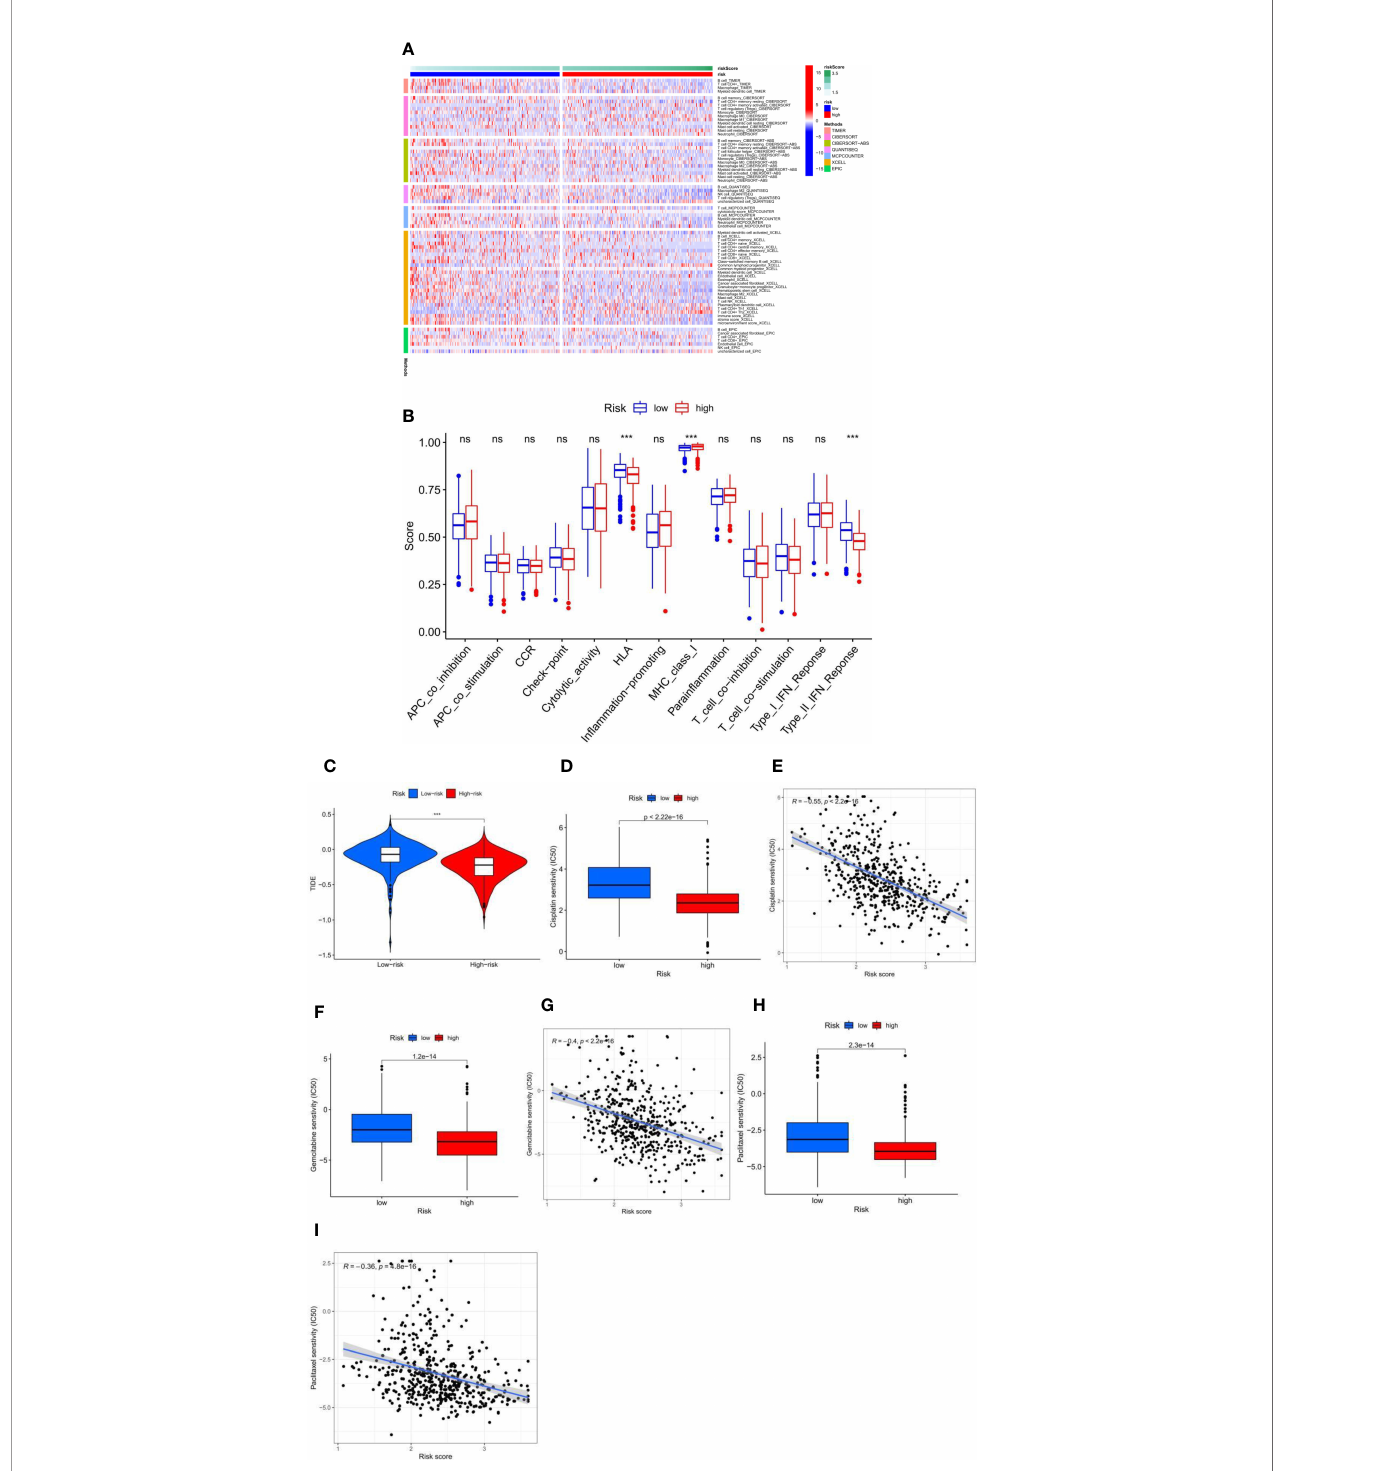
FIGURE 4 | (A) The immune in fi ltration of immune cell types in high-risk and low-risk patients in the TCGA-LUAD cohort. (B) Analysis of immune function in high-risk and low-risk patients in the TCGA-LUAD cohort. ***p < 0.001, ns p > 0.05. (C) High-risk and low-risk LUAD patients with TIDE scores in the TCGA-LUAD cohort. (D – I) Fatty acid metabolism score and cisplatin (D, E) , gemcitabine (F, G) , and paclitaxel (H, I) chemotherapeutic drug sensitivity analysis in the TCGA-LUAD